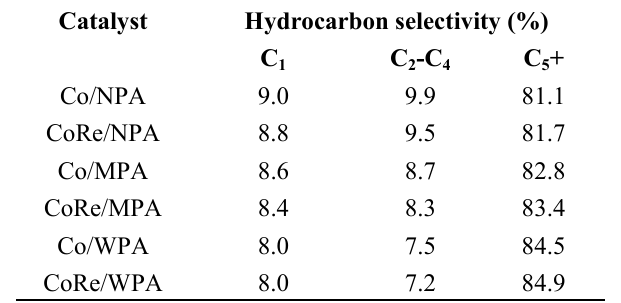
Table 6. Product selectivities from data taken at 210 °C, 2.0 MPa, H 43–44% (adapted with permission from [17] Copyright 2009, Elsevier) over 20%Co/ γ -Al catalysts without or with 0.5%Re using narrow pore (7.4 nm), medium pore (12.3 nm), and wide pore (16.7 nm)